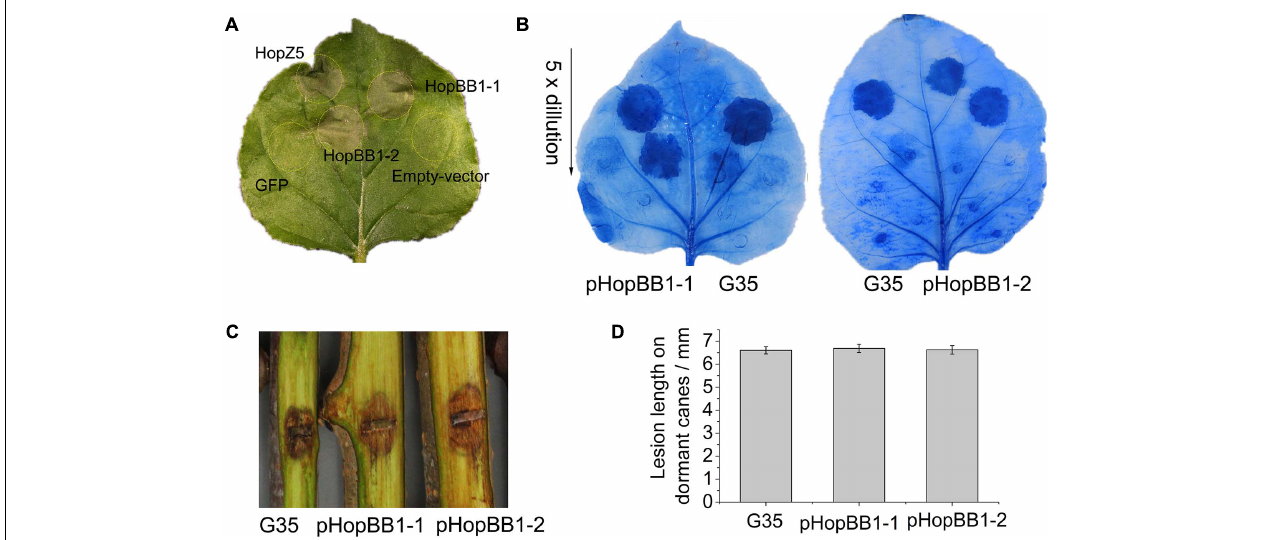
FIGURE 6 | Type III effectors HopBB1-1 and HopBB1-2 induce hypersensitivity response (HR) in non-host Nicotiana benthamina leaves and enhance the HR-inducing ability of G35. (A) HR induction of heterologously expressed HopBB1-1 and HopBB1-2. The type III effector HopZ5 is used as the positive control, while the GFP and the empty-vector pCAMIBA1300 are used as the negative control. Four-weeks-old N. benthamina leaves were infiltrated with Agrobacterium tumefaciens strain GV3101 carrying certain plasmid at a concentration of 10 8 CFU/mL, and were photographed at 36-hour post infiltration. The experiments were repeated three times with similar results. (B) Constitutively expressed HopBB1-1 or HopBB1-2 in G35 enhanced HR-inducing ability. (C,D) HopBB1-1 and HopBB1-2 constitutively expressed alone in G35 did not increase the pathogenicity of the pathogen on